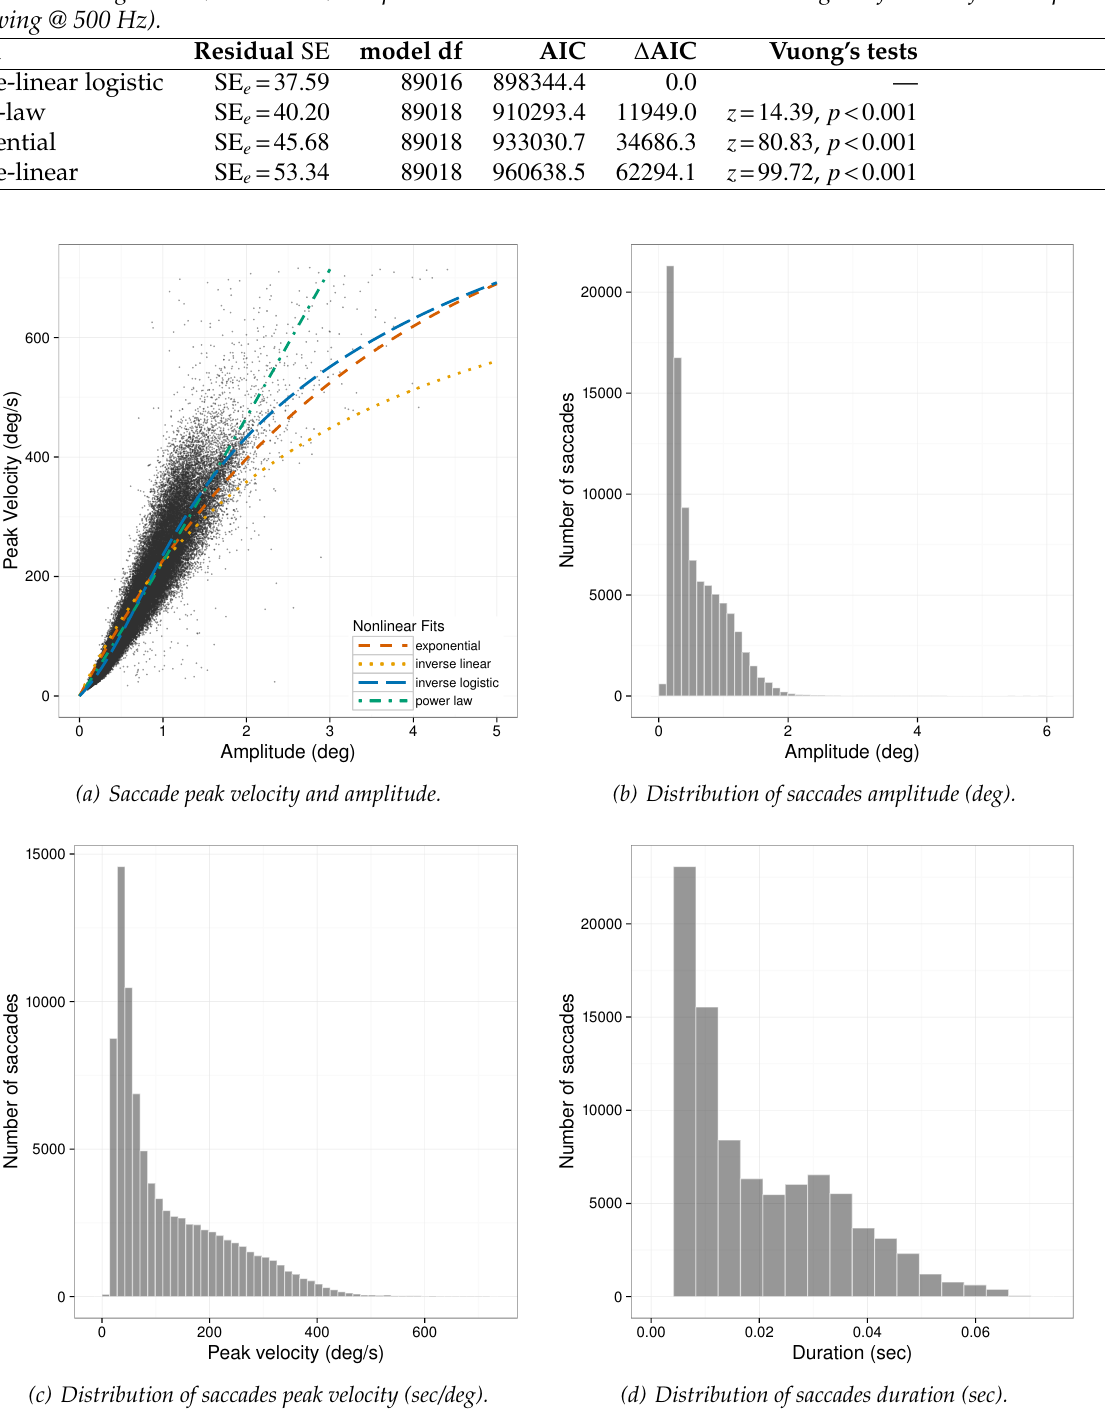
Figure 10 . Experiment 3. Distribution of saccade amplitude (b), peak velocity (c), and duration (d). Figure (a) depicts the nonlinear relationship between peak velocity and amplitude with different function fits. Data were captured at 500